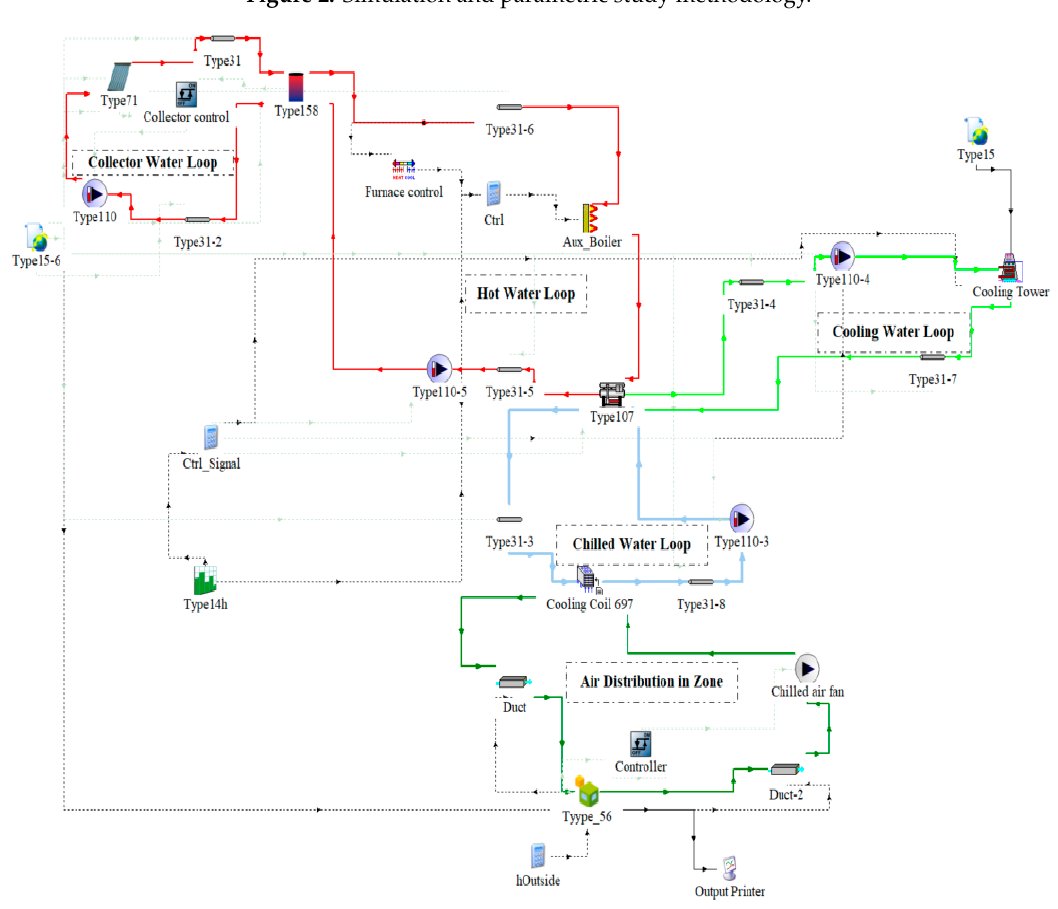
Figure 3. Solar absorption cooling system simulated in TRNSYS.